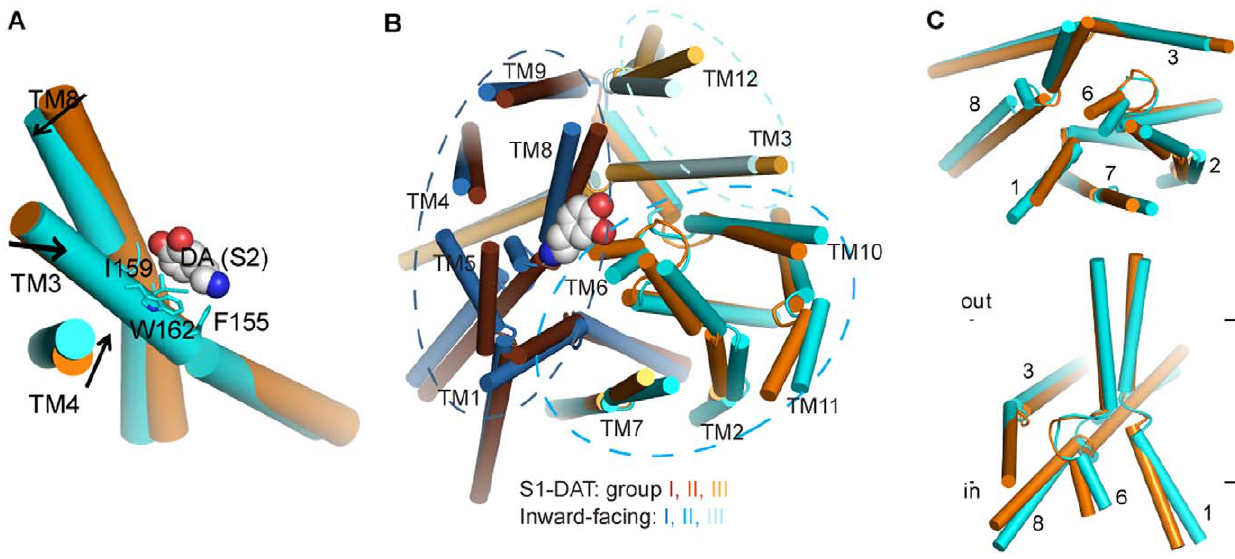
Figure 5. The global rearrangement from S1-DAT to the inward-facing conformation. ( A ) The global rearrangement of TMs3, 4 and 8 at the extracellular side, from S1-DAT (orange) to the inward-facing conformation (cyan). Proteins are aligned with RMSDTT [53] using the entire models. In the inward-facing conformation, TM3 residues F155 3.49 , I159 3.53 and W162 3.56 (in sticks) are in direct contact with DA (in spheres, colored by atom type) in the S2 site. ( B ) Viewed from the intracellular side, the movement of the 12 intracellular TM segments (rendered in cartoon) can be partitioned into three groups as indicated by the dotted circles (see text). During the transition to the inward-facing conformation, the first group (colored in chocolate brown for S1-DAT and blue for the inward-facing conformation) moves outward; the second group (orange for S1-DAT and cyan for the inward-facing conformation) moves outward and away from the first group; the third group (yellow for S1-DAT and pale cyan for the inward-facing conformation) moves inward. DA is rendered in spheres and colored by atom types. ( C ) The global movement of selected TMs viewed from the intracellular side (top panel) and parallel to the membrane (bottom panel). During the transition, the extracellular ends of segments TM1b and TM6a do not move, while the intracellular end segments TMs1a and 6b swing away, non-symmetrically, from TMs 3 and 8 to open the substrate translocation pathway. TM1a moves substantially more, thereby distancing itself from TM6b.